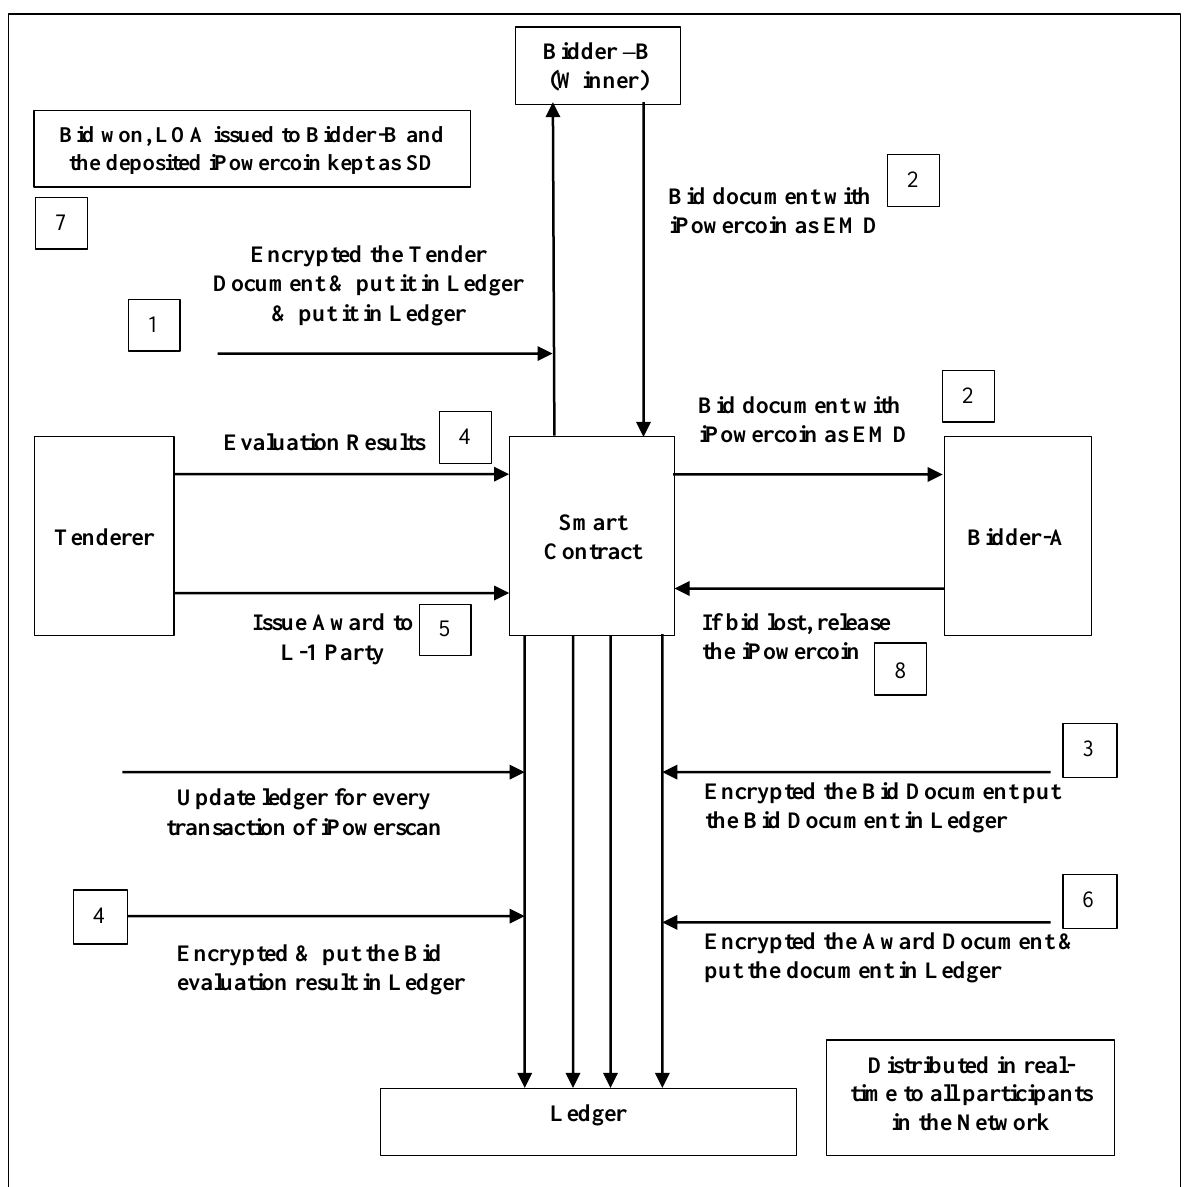
Figure 4. Proposed bidding process utilizing Smart Contracts and Blockchain